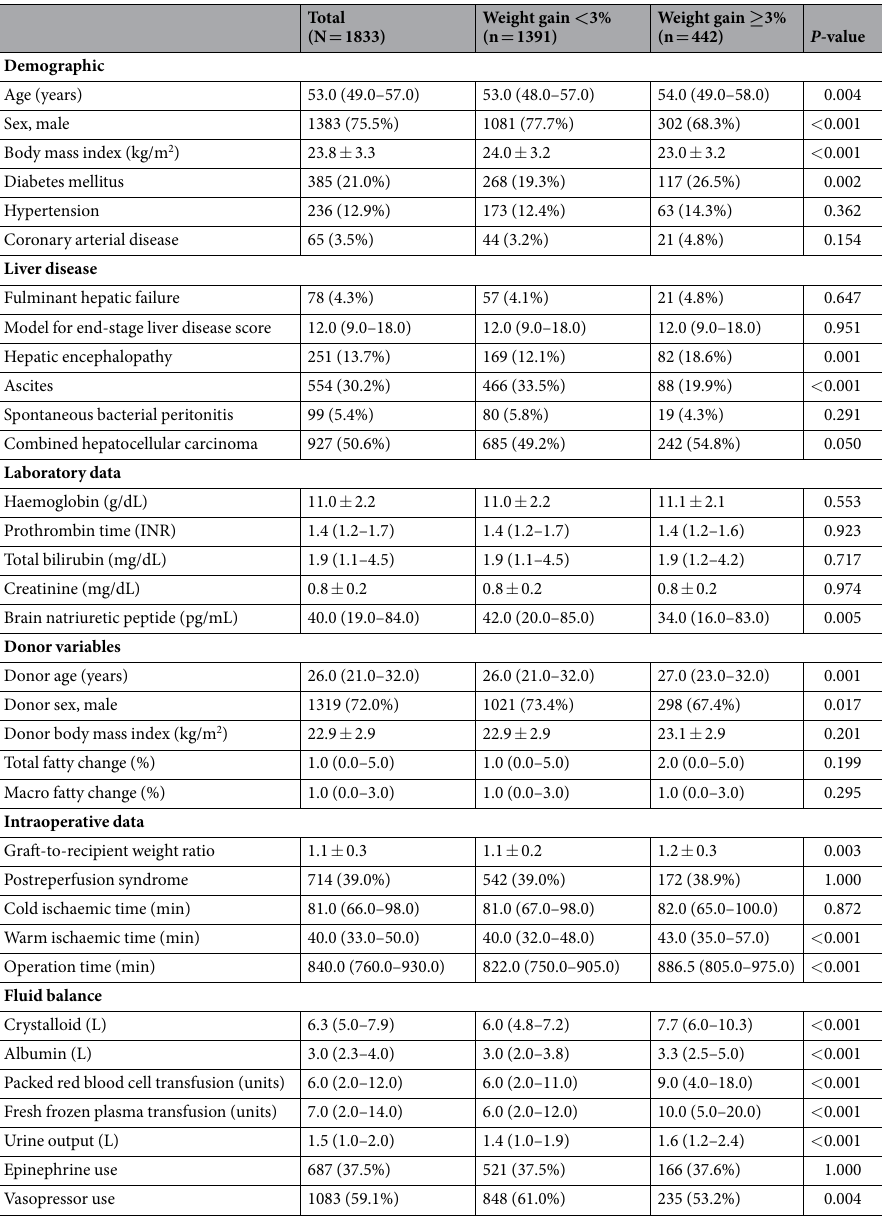
Table 1. Baseline characteristics and intraoperative data of living donor liver transplantation recipients and donors. INR, international normalized